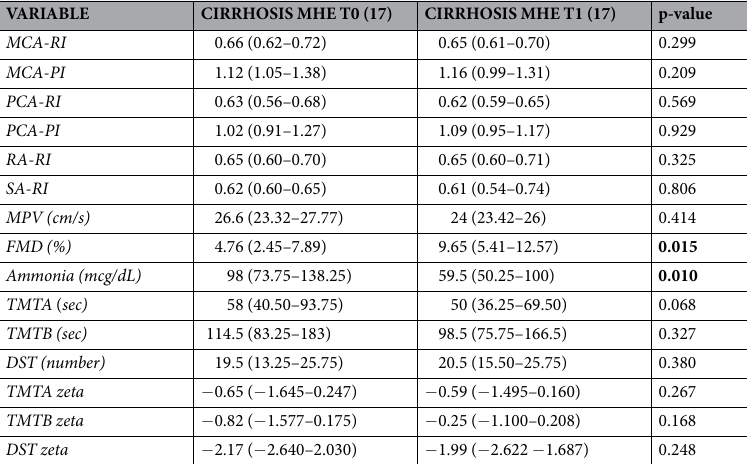
Table 2. Variation of cerebral and splanchnic vascular parameters, endothelial function, ammonia serum level and neuropsychological tests in patients who received rifaximin treatment. Values are expressed as median (IQR)/count